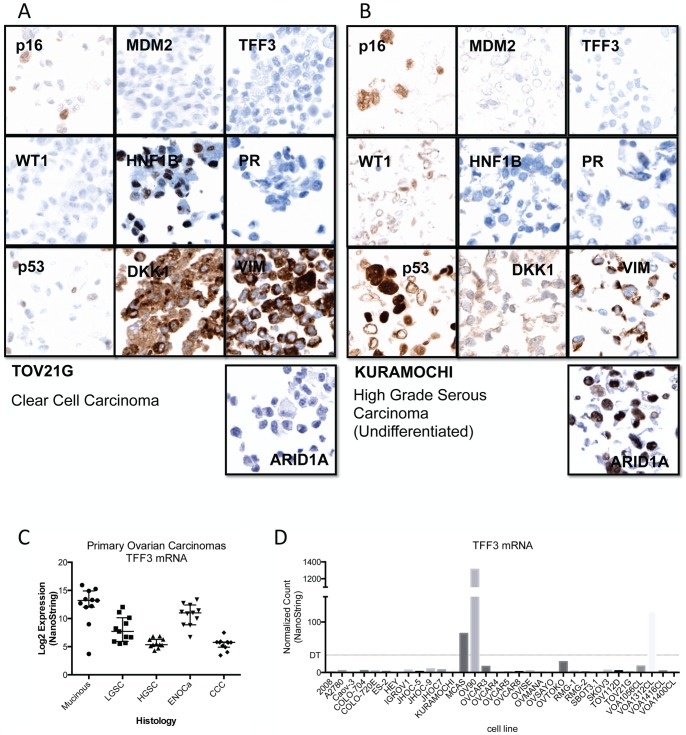
Prediction of histotype was in part based on the COSP algorithm using 9 IHC markers [2].(A–B) representative IHC from a typical high-grade serous ovarian carcinoma cell line, Kuramochi, and a clear cell carcinoma cell line, TOV21G. In addition to the 9-marker COSP panel, IHC for ARID1A (BAF250a) is also shown as a mutation surrogate. (C) TFF3 mRNA expression from 60 ovarian cancer samples (12 of each histotype). As noted previously high expression is most prevalent in MUC, followed by ENOCa and LGSC [2], [4]. Expression in our pilot cohort suggests the highest levels of TFF3 in MUC, which was significantly higher than all other groups (Tukey's adjusted p<0.01); no other pairwise comparisons had p<0.05. (D) TFF3 mRNA detected in ovarian cancer cell lines was used in place of an IHC score as the secreted TFF3 was considered a poor biomarker for cell culture conditions. Any cell line with measurable TFF3 mRNA above the NanoString detection threshold (see methods) was considered positive (score of 1 for use in the COSP algorithm).